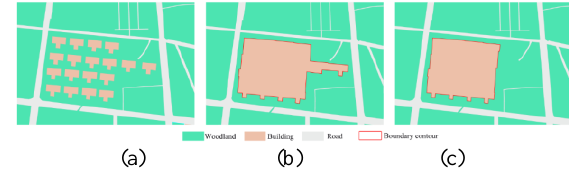
Figure 11. Comparison of aggregation results for the complex grid pattern. (a) Original data; (b) result of mixed integer programming; (c) result of the method proposed in this paper. Figure 10 indicates that the mixed integer programming